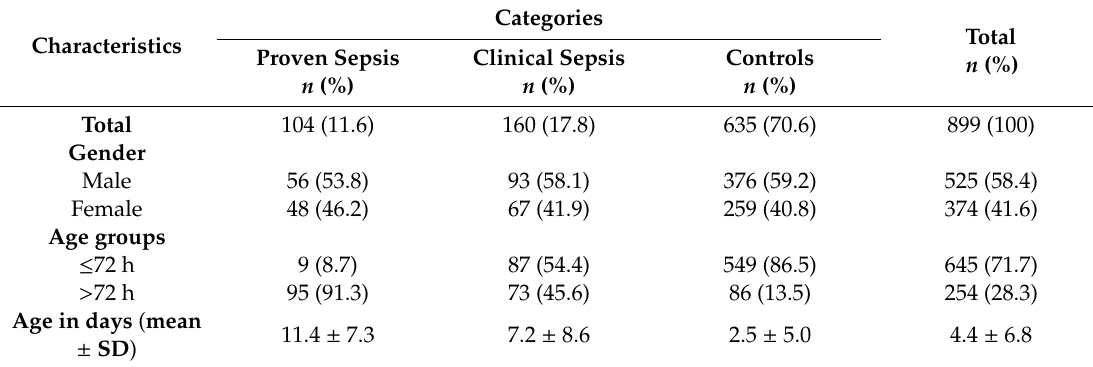
Table 1. Demographic characteristics of neonates according to the categories.